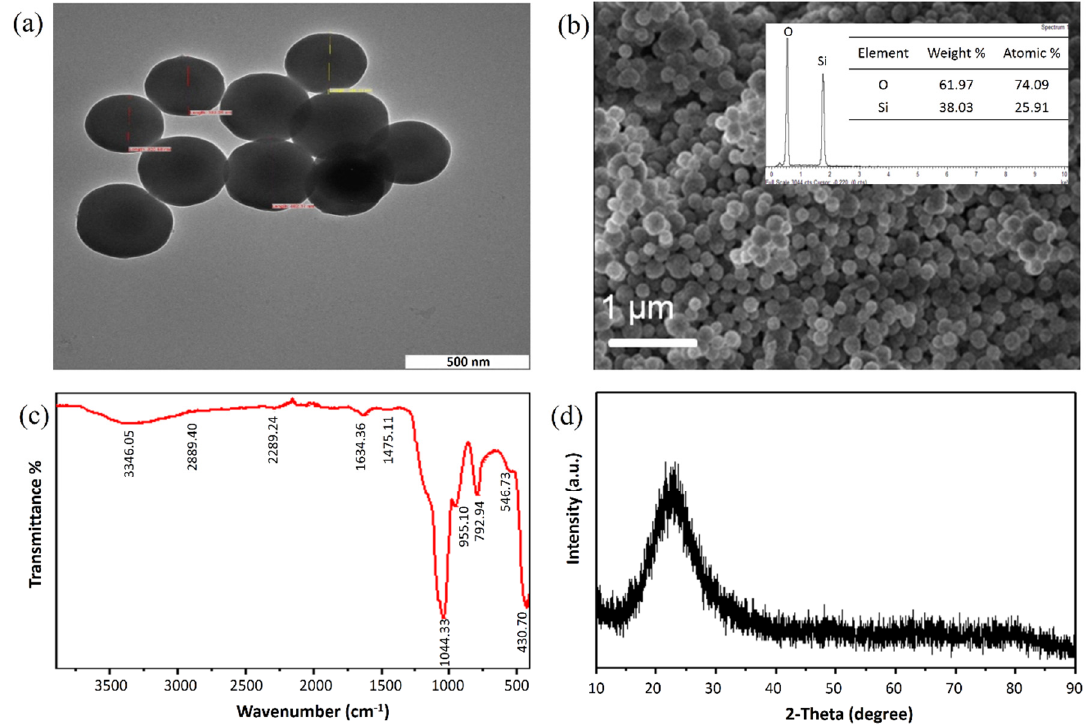
Figure 2. ( a ) TEM image, ( b ) FESEM image and the EDX profile (inset), ( c ) FTIR spectra, and ( d ) XRD pattern of the synthesized SiNPs.